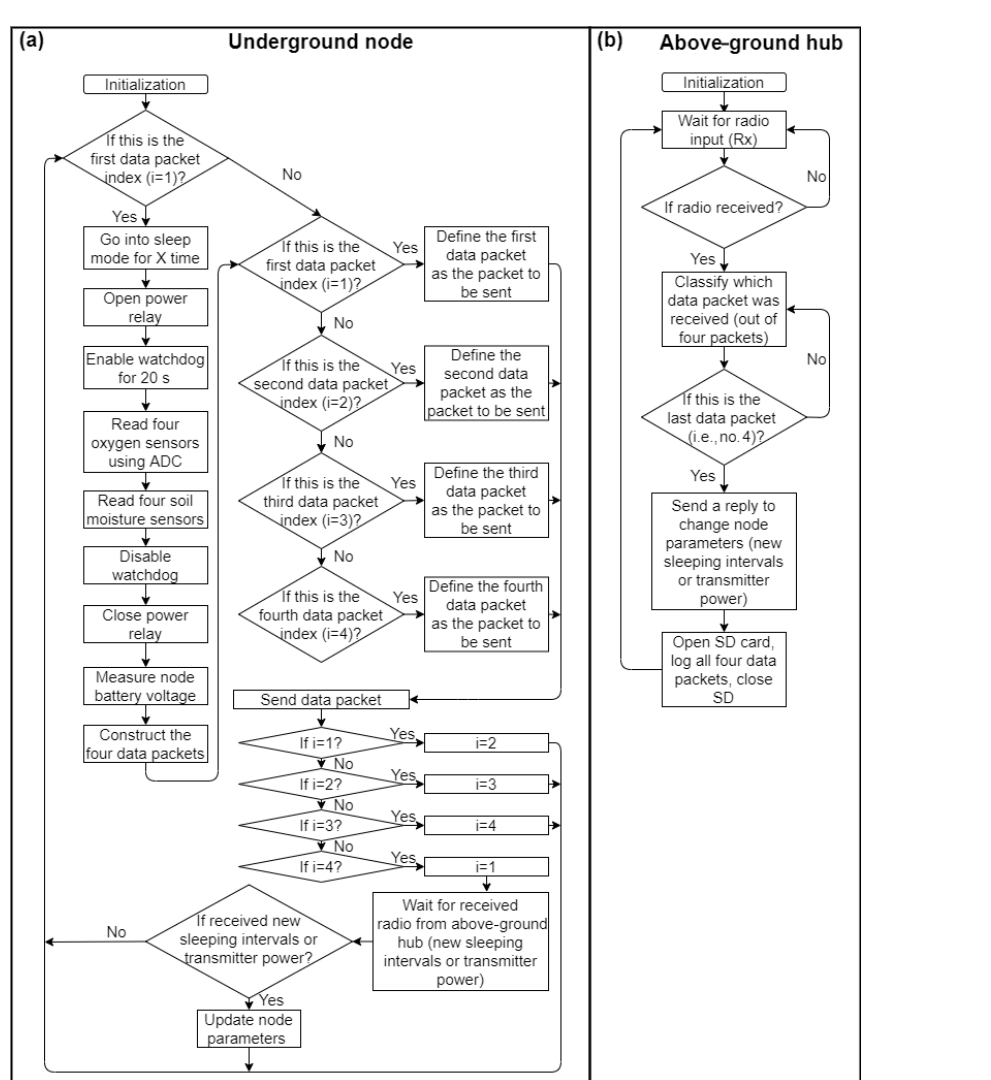
Figure 2. Flow chart for underground node (a) and above-ground hub (b) . A description for each step is given within the code (Supplement, Sect.